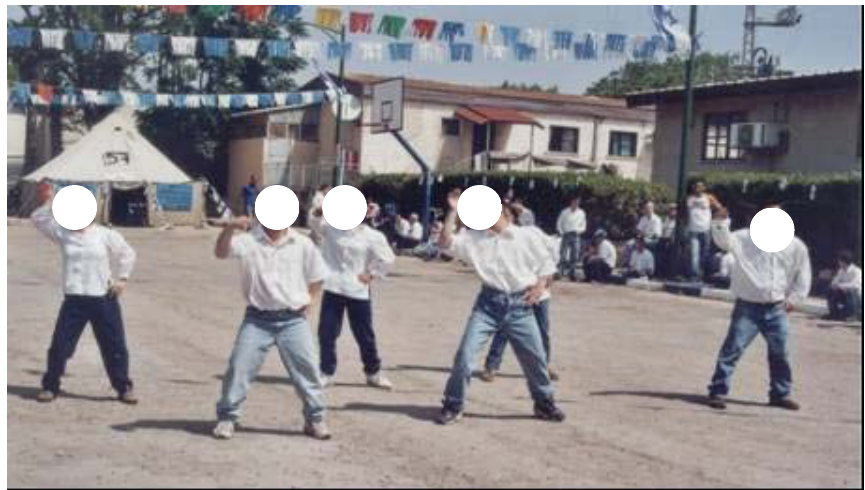
FIGURE 1. The dance group during